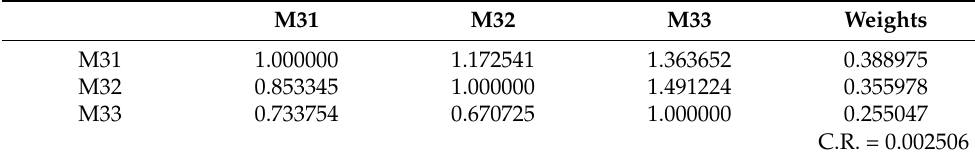
Table 12. Defuzzified pair-wise comparative matrix with parameter local weight for targets.